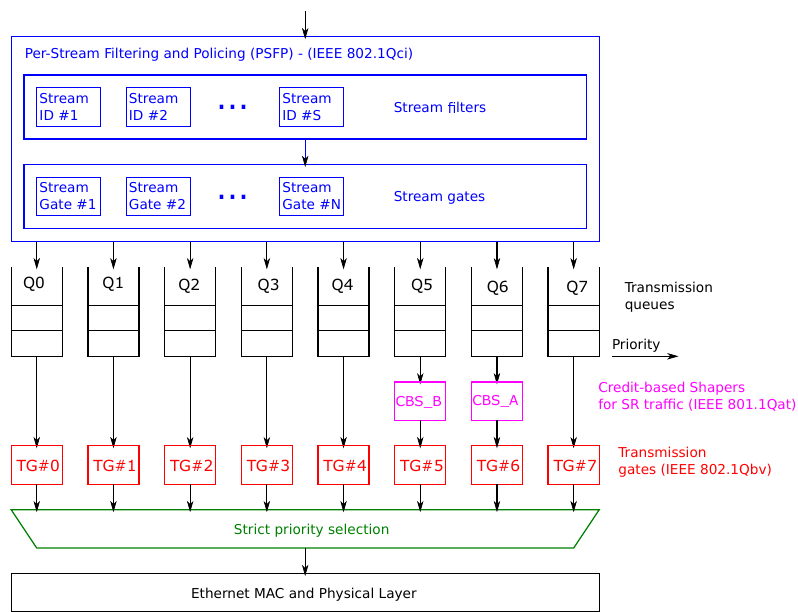
Figure 1. Ethernet port forwarding architecture according to the IEEE